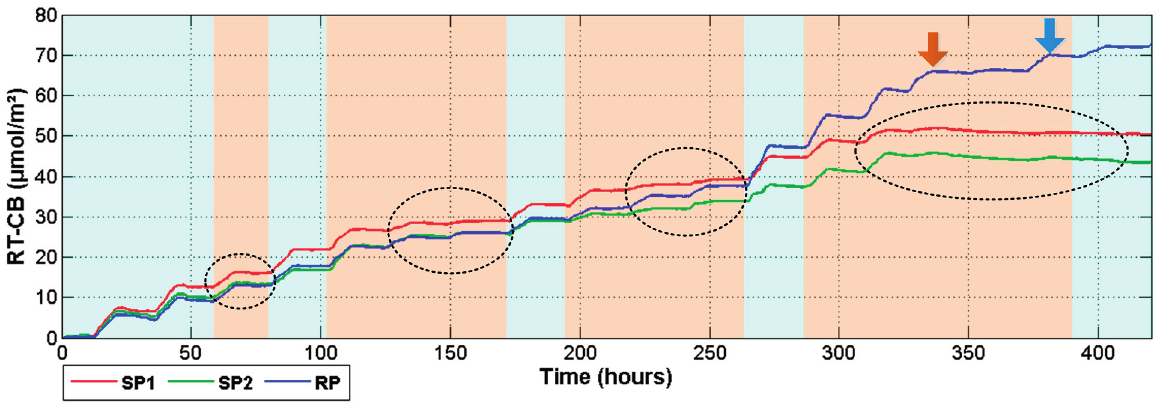
Figure 11. Real Time-Carbon Balance ( RT-CB